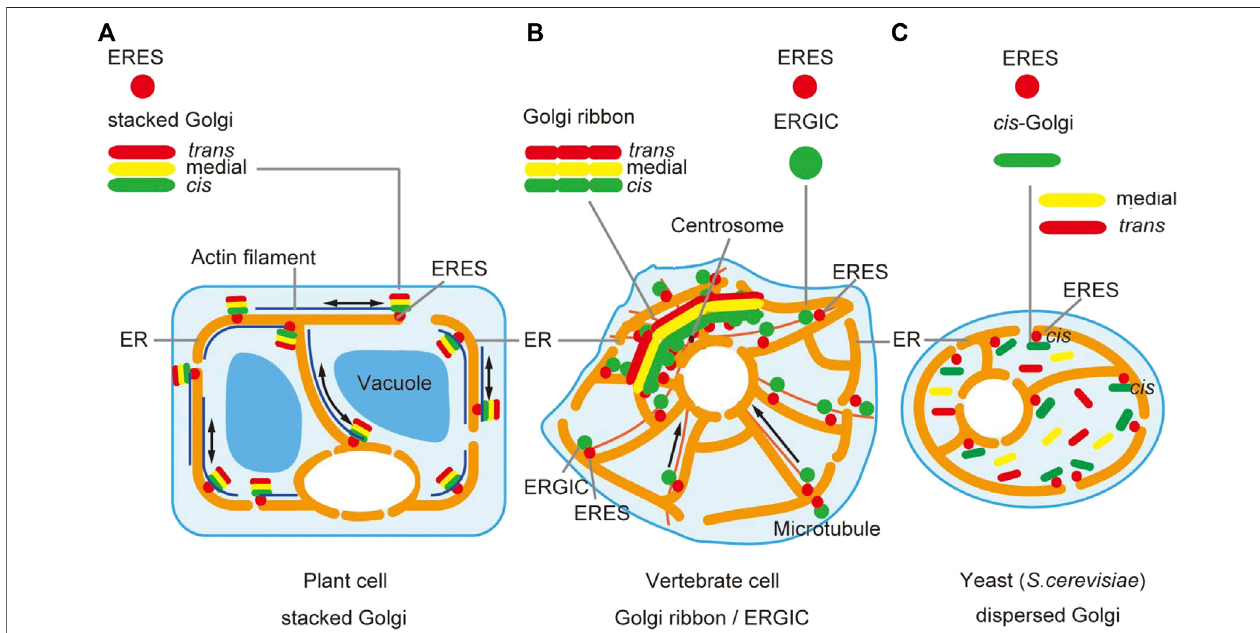
FIGURE 1 | Spatial organization of the Golgi. The spatial arrangement of the Golgi apparatus looks different among species. (A) In plant cells, Golgi cisternae ( cis , medial, and trans ) are beautifully layered in single stack units, which are scattered in the cytoplasm. Model animals of invertebrates, Drosophila and C. elegans , show a similar pattern. (B) In vertebrate animals like mammals, Golgi stacks are concentrated at the perinuclear centrosomal region often in an interconnected fashion to form a gigantic Golgi ribbon structure. (C) In the budding yeast S. cerevisiae , Golgi cisternae do not stack and are individually scattered in the cytoplasm. Note that ERES (ER exit sites) are very frequently observed in the very vicinity of the Golgi stack (A) or ERGIC (ER-Golgi intermediate compartment) (B) or cis -Golgi (C) [modi fi ed from Kurokawa et al. (2019)].